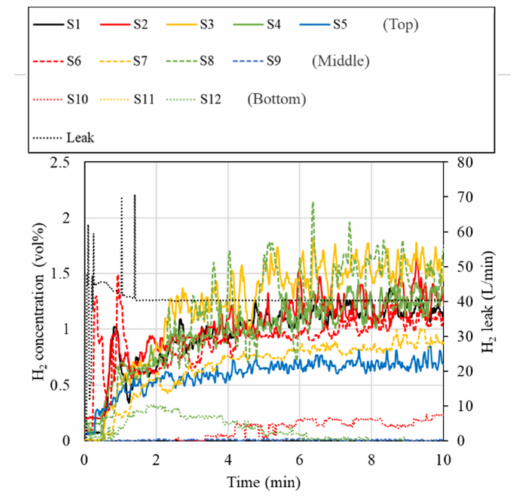
Figure 5. Hydrogen concentration variation by leak (Case 15: hydrogen supply pressure 3 kPa, leak hole 1/8 inch, leak amount 40 L/min, no vent opening, and fully operational